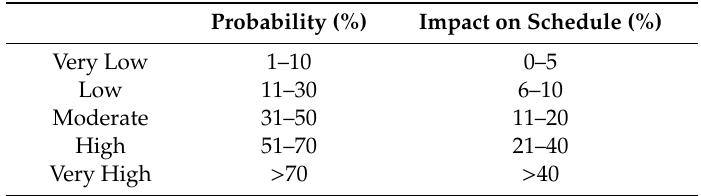
Table 4. The probability and impact scale used in the questionnaire [42].